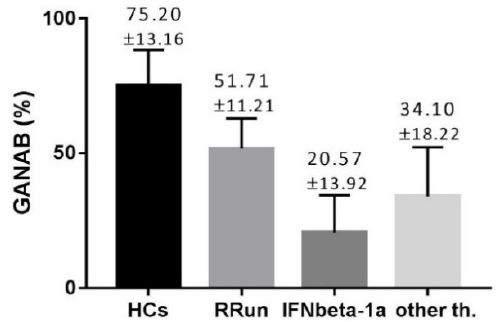
Figure 2. The modular expression of GANAB in all compared groups. HCs, control group; RRun, relapsing remitting untreated MS patients; IFNbeta-1a, MS patients treated with IFNbeta-1a; other th., MS patients treated with other than IFN treatment. Values are shown as percentages means with standard deviation, normalized on beta-actin.